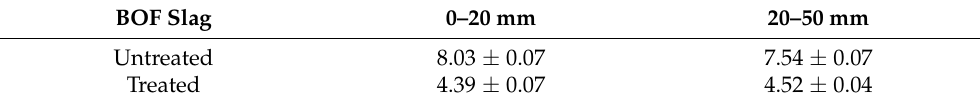
Table 2. Free lime content (%) of BOF slag before and after treatment.